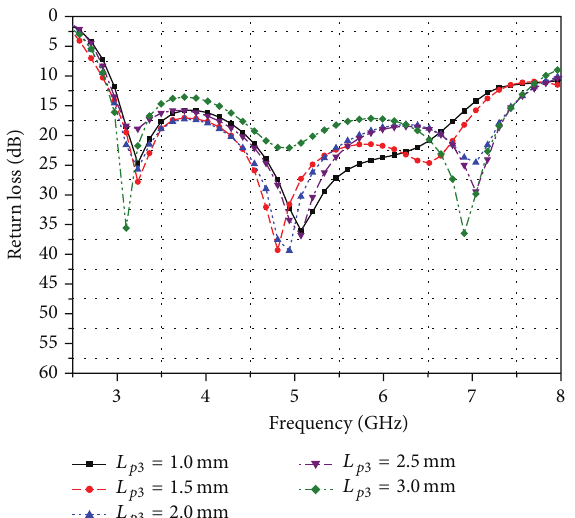
Figure 5: Simulated return loss against frequency for the proposed CPW-fed two-sided T strip wideband microstrip antenna with various values of 𝑊 𝑝1 ; other parameters are the same as listed in